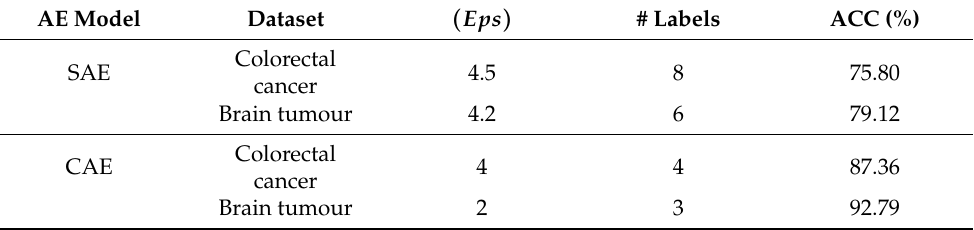
Figure 5. The CAE for unlabelled images; first row: the original images of the dataset, second row: the reconstructed images. Table 4. The classification performance of ResNet-50 pre-trained model on the pseudo-labelled Colorectal cancer and Brain tumour